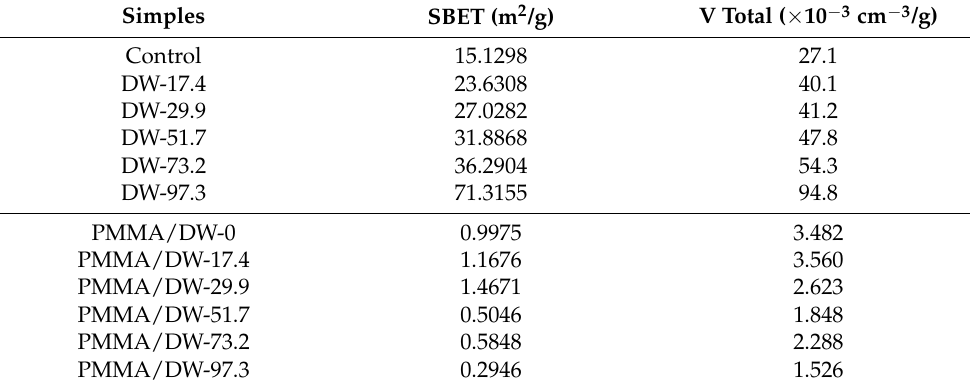
Table 2. Specific surface area (SBET) and total pore volume (V total) of the delignified wood (DW) and polymethyl methacrylate/delignified wood (PMMA/DW).